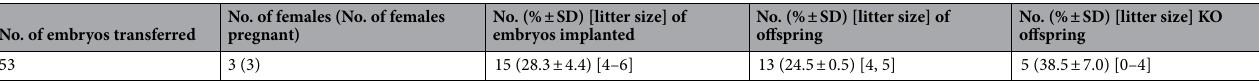
Table 2. Development of frozen-warmed embryos with genome editing performed using the TAKE method, which were then transferred to females with pseudopregnancy induced by sonic vibration on the day of embryo transfer. KO knockout, TAKE Technique for Animal Knockout System by